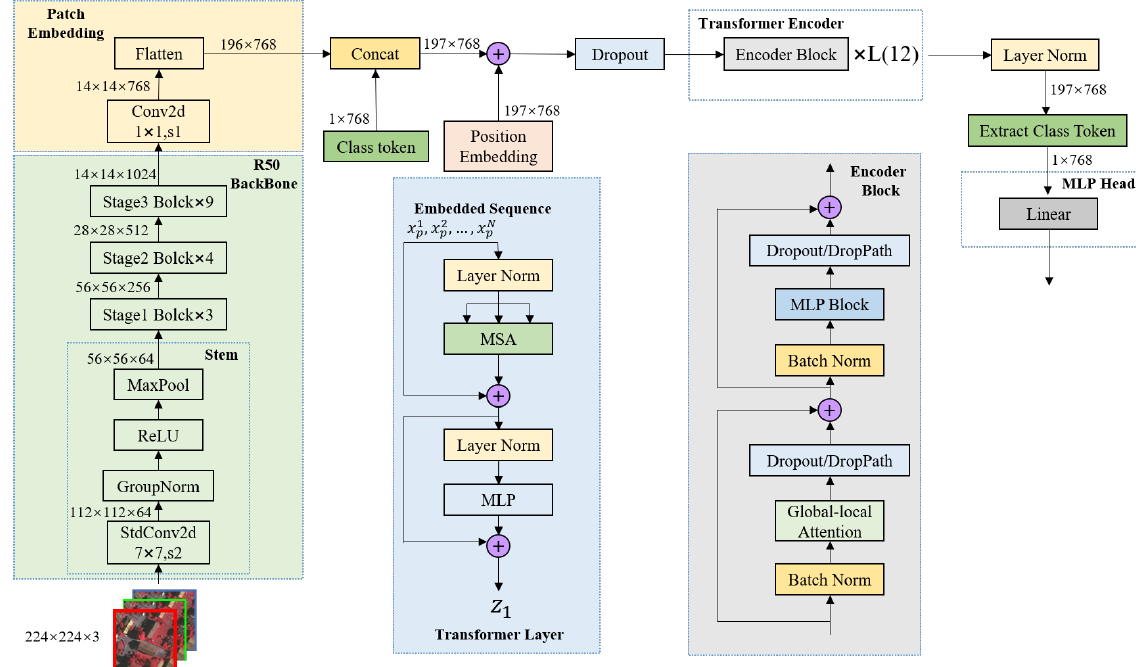
Figure 3. The encoding part structure of the